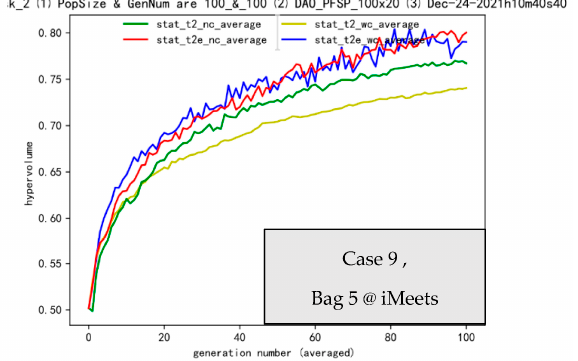
Figure 7. In cases 1, 2, ..., 9, we study the search dynamic in Bag 5 for ETO interpretability. “stat” denotes statistics of hypervolume in terms of both Cmax optimization objective and TFT optimization objective towards Pareto characterization for evaluation. Moreover, task t2_nc is the baseline NSGAII, without clustering and transferring. Because NSGAII is a widely used standard algorithm.